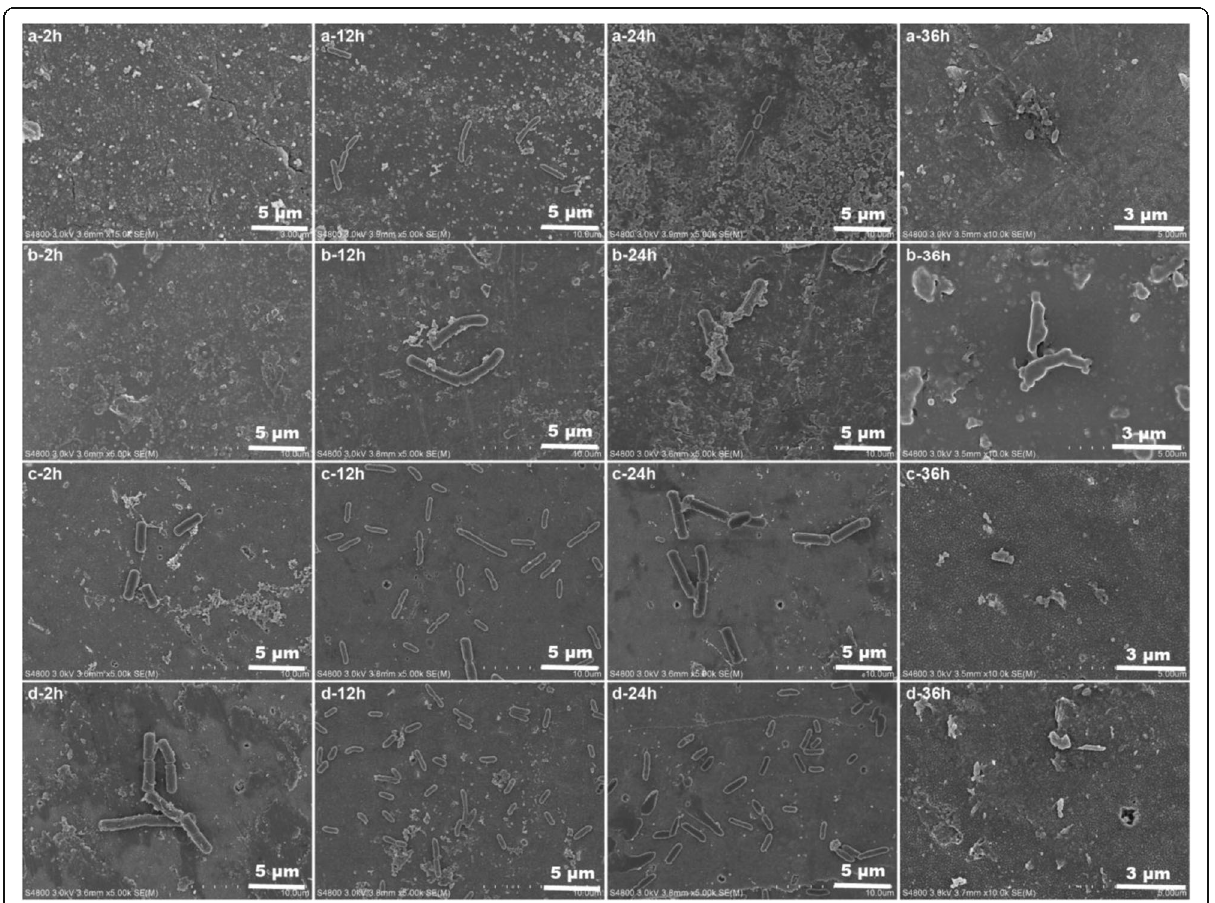
Fig. 8 SEM images of the biofilms on the zinc oxide films prepared on PAA with different time of two-step anodization duration a 0 min, b 40 min, c 60 min, and d 80